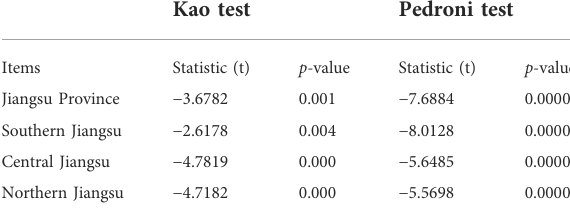
TABLE 4 Results of Kao and Pedroni